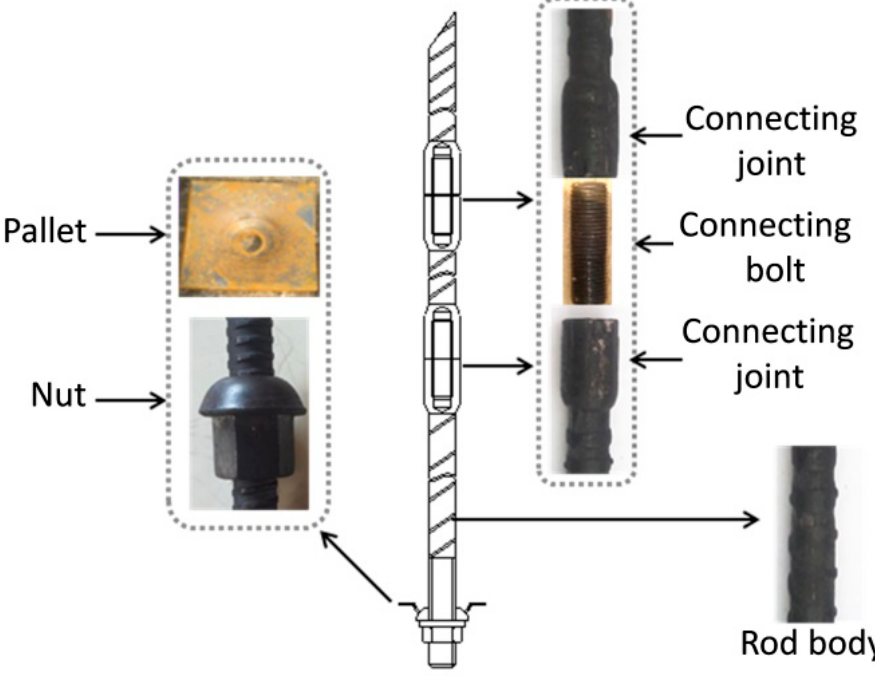
Figure 15. Structural composition of long-extension bolt.